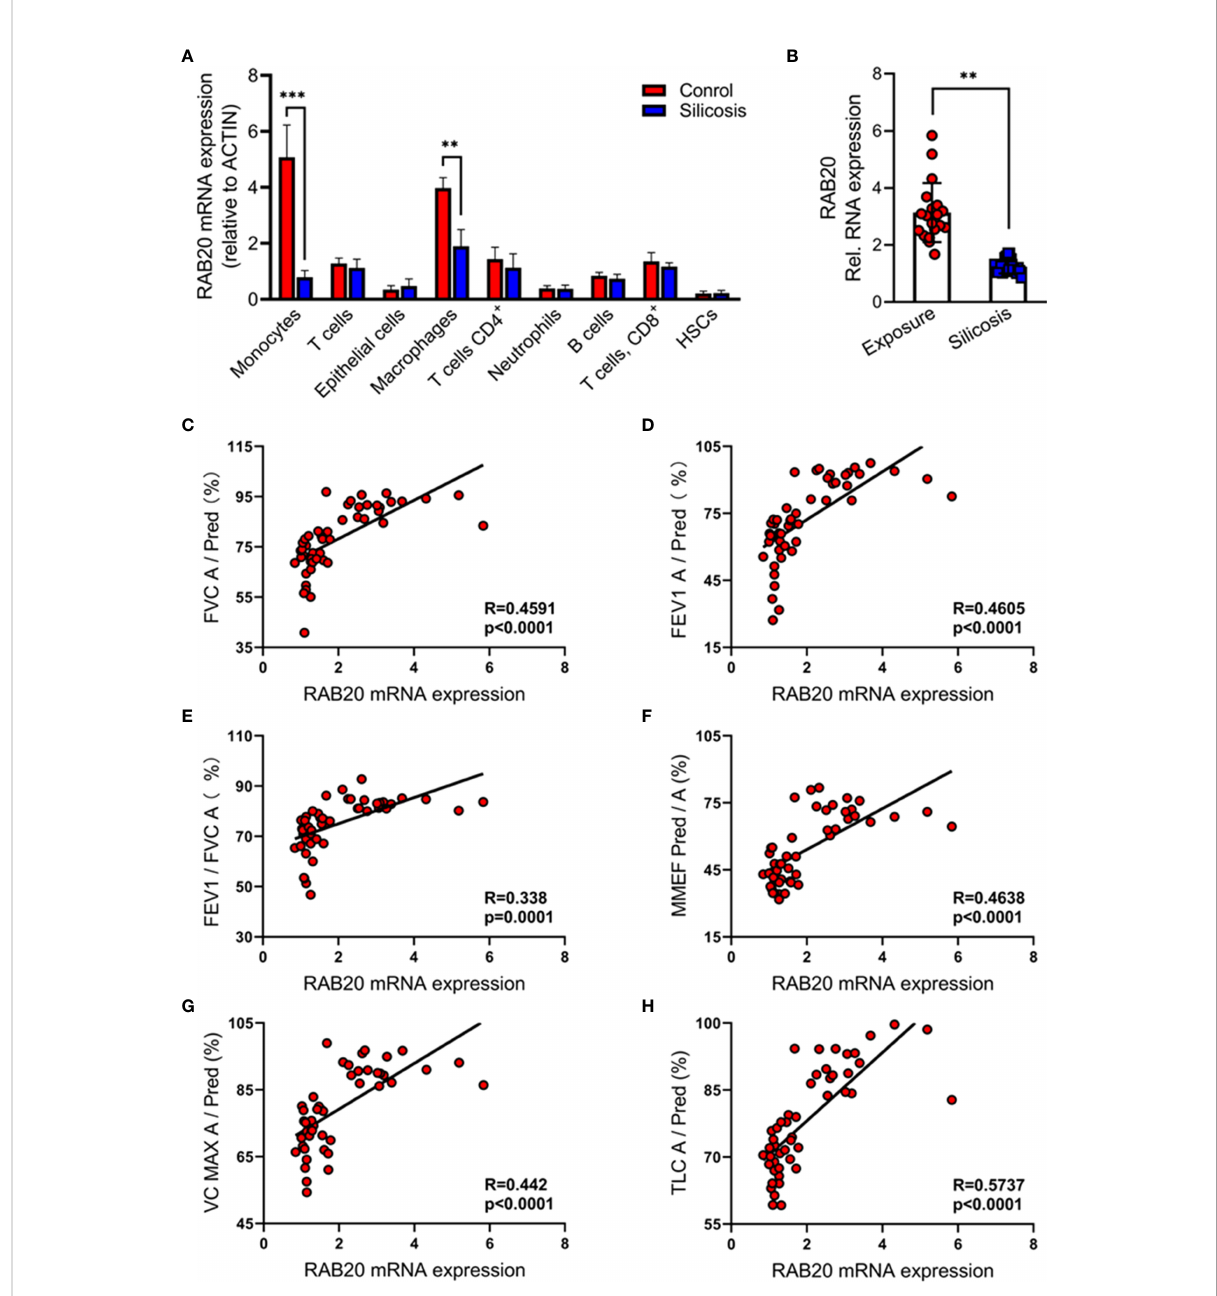
FIGURE 1 Reduced RAB20 in monocytes and macrophage was strongly associated with the occurrence of silicosis in mine workers. (A) Expression of RAB20 genes in monocytes, T cells, macrophages, CD4 + T cells, neutrophils, CD8 + T cells, B cells, and HSCs based on publicly available single-cell RNA- seq data using bronchoalveolar lavage fl uid cells obtained from silicosis patients and their healthy co-workers. (B) The RAB20 mRNA expression detected by qPCR in bronchoalveolar lavage fl uid cells from exposure and silicosis patients. (C) The mRNA levels of RAB20 signi fi cantly correlated with the lung function indexes (actual FVC/predicted FVC) in silicosis patients. (D) The mRNA levels of RAB20 signi fi cantly correlated with the lung function indexes (actual FEV1/predicted FEV1) in silicosis patients. (E) The mRNA levels of RAB20 signi fi cantly correlated with the lung function indexes (actual FEV1/actual FVC) in silicosis patients. (F) The mRNA levels of RAB20 signi fi cantly correlated with the lung function indexes (actual MMEF/predicted MMEF) in silicosis patients. (G) The mRNA levels of RAB20 signi fi cantly correlated with the lung function indexes (actual VC MAX/ predicted VC MAX) in silicosis patients. (H) The mRNA levels of RAB20 signi fi cantly correlated with the lung function indexes (actual TLC/predicted TLC) in silicosis patients. **p < 0.01; ***p < 0.001 (by unpaired/two-tailed t test or one-way and two-way ANOVA test). Data are shown as mean ± SEM from three independent